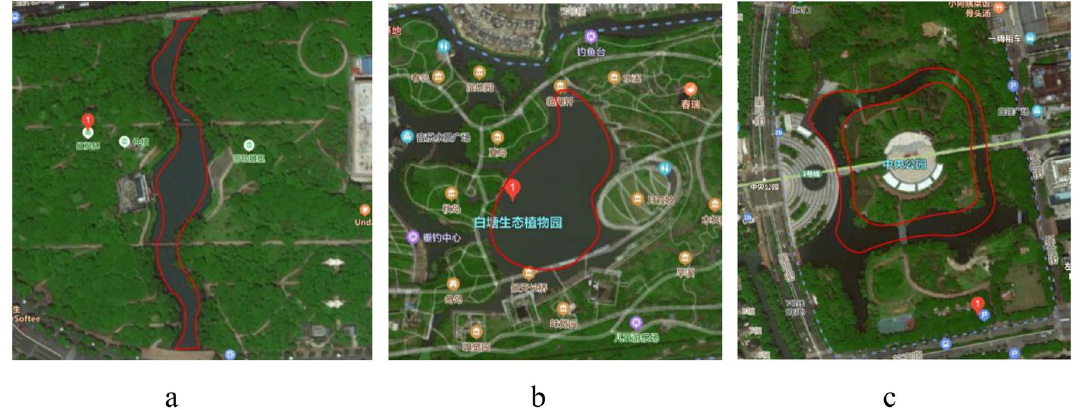
Figure 2. Satellite images and numerical simulations of representative water shapes. ( a ) Banded water (Hongfenglin Park); ( b ) massive water (Baitang Botanical Garden); ( c ) annular water (Central Park) ( https:// map. baidu. com/ searc h/% E8% 8B% 8F% E5% B7% 9E% E4% B8% AD% E5% A4% AE% E5% 85% AC% E5% 9B% AD/@ 13432 986. 83040 3794,36519 10. 90229 1707,17. 87z/ mapty pe% 3DB_ EARTH_ MAP? query type= s& da_ src= share url& wd=% E8% 8B% 8F% E5% B7% 9E% E4% B8% AD% E5% A4% AE% E5% 85% AC% E5% 9B% AD&c= 1& src= 0& pn= 0& sug= 0&l= 7&b= (12751 614. 67284 1096,32376 06. 54451 1262; 15633 781. 77495 08,46441 64. 13548 8758) & from= webma p& biz_ forwa rd=% 7B% 22sca ler% 22: 1,% 22sty les% 22:% 22pl% 22% 7D& device_